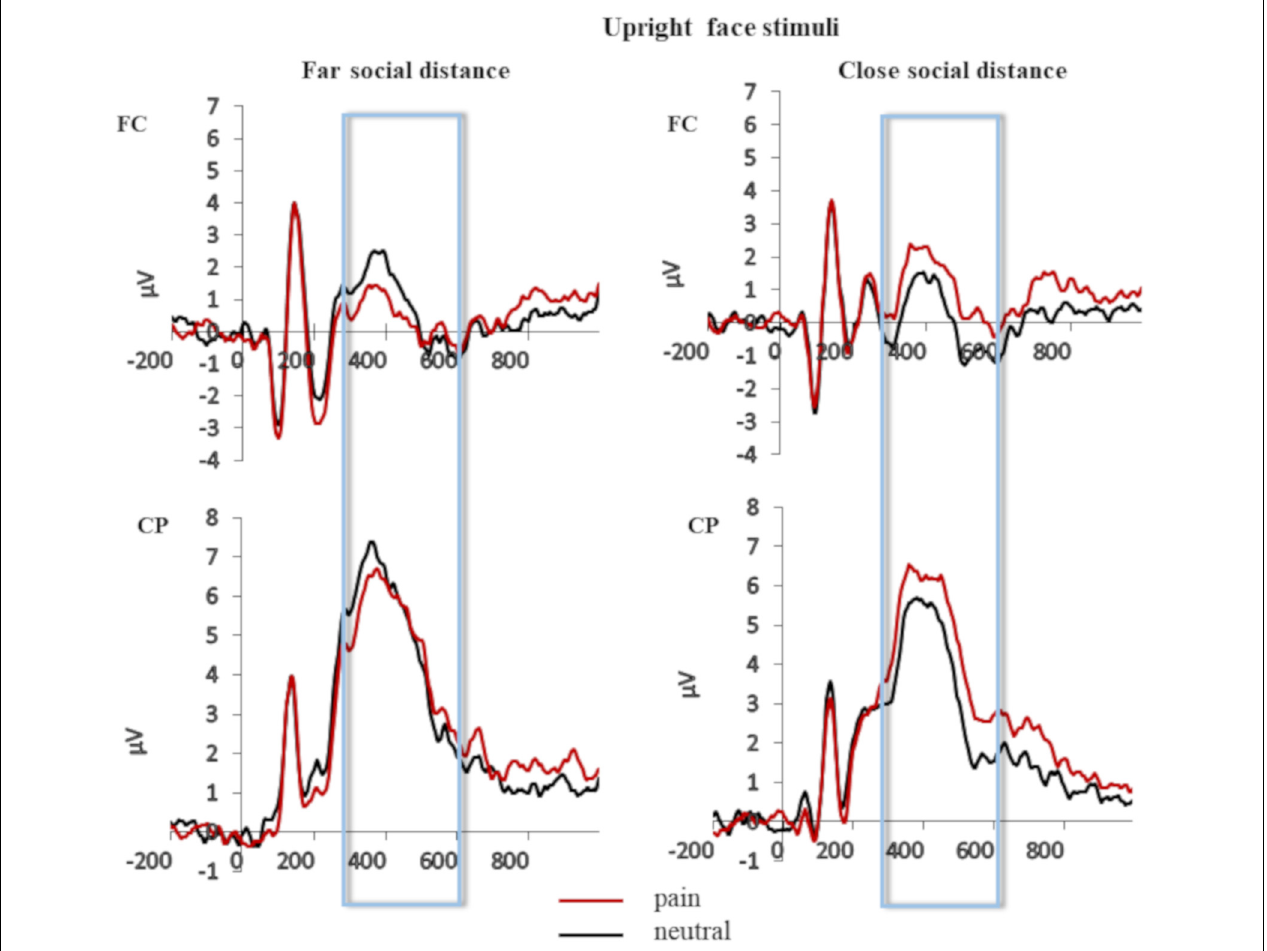
FIGURE 2 | Grand averages of the face-locked ERP waveforms for the upright face stimuli elicited in the pain and neutral stimulation conditions separately for pooled fronto-central (FC) and centro-parietal (CP) electrode site and for close and far social distance.